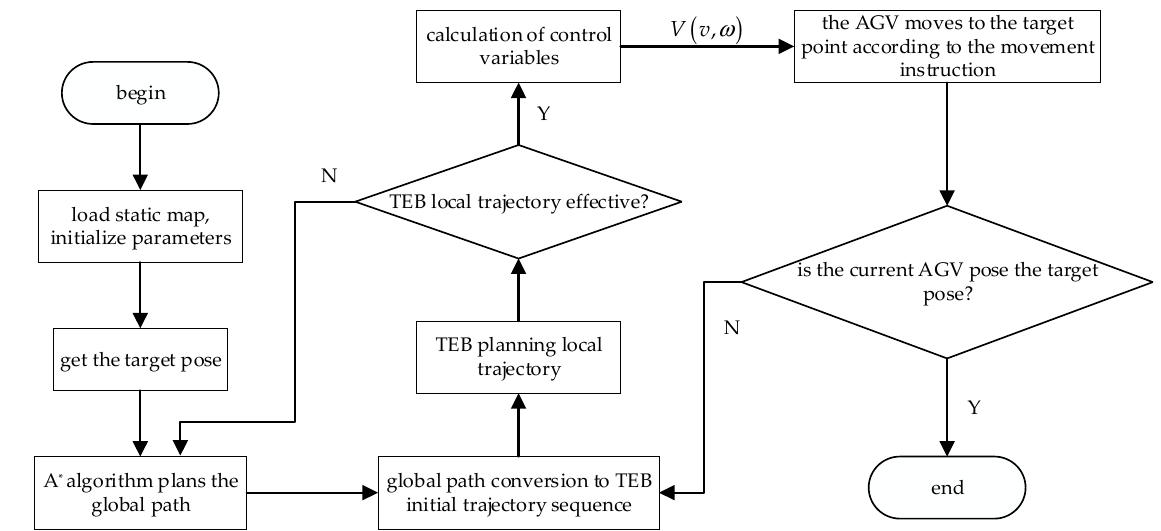
Figure 4. Path planning flow chart based on A* algorithm and improved TEB algorithm.